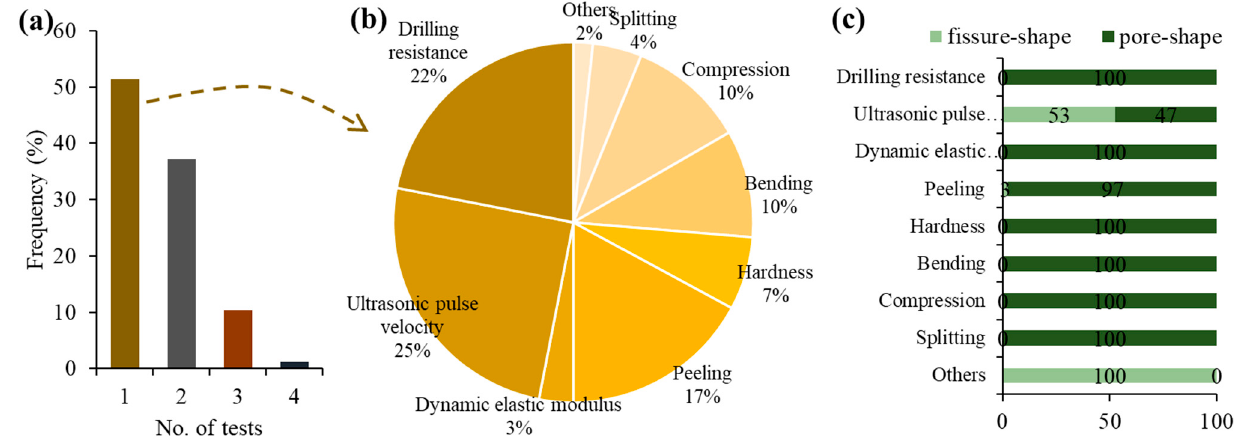
Figure 5. Distribution of the number of tests used to assess the strengthening effect of stone consoli- dants ( a ), distribution of the tests used when only one is employed ( b ), characteristics of the stones in relation to the types of voids when only one test is employed ( c ).